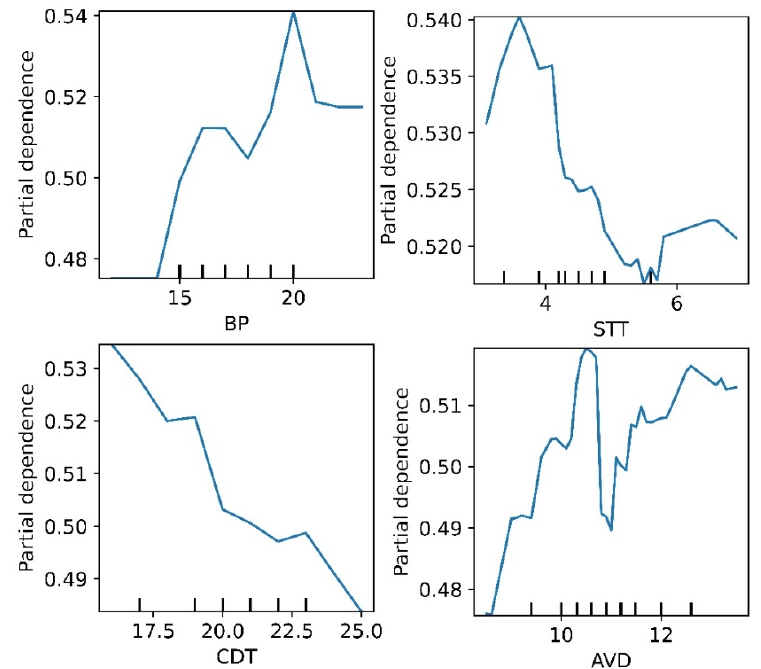
Figure 10. Partial dependence plots of four predictor variables of interest and their marginal contribution to the model predictions. (Source: author).